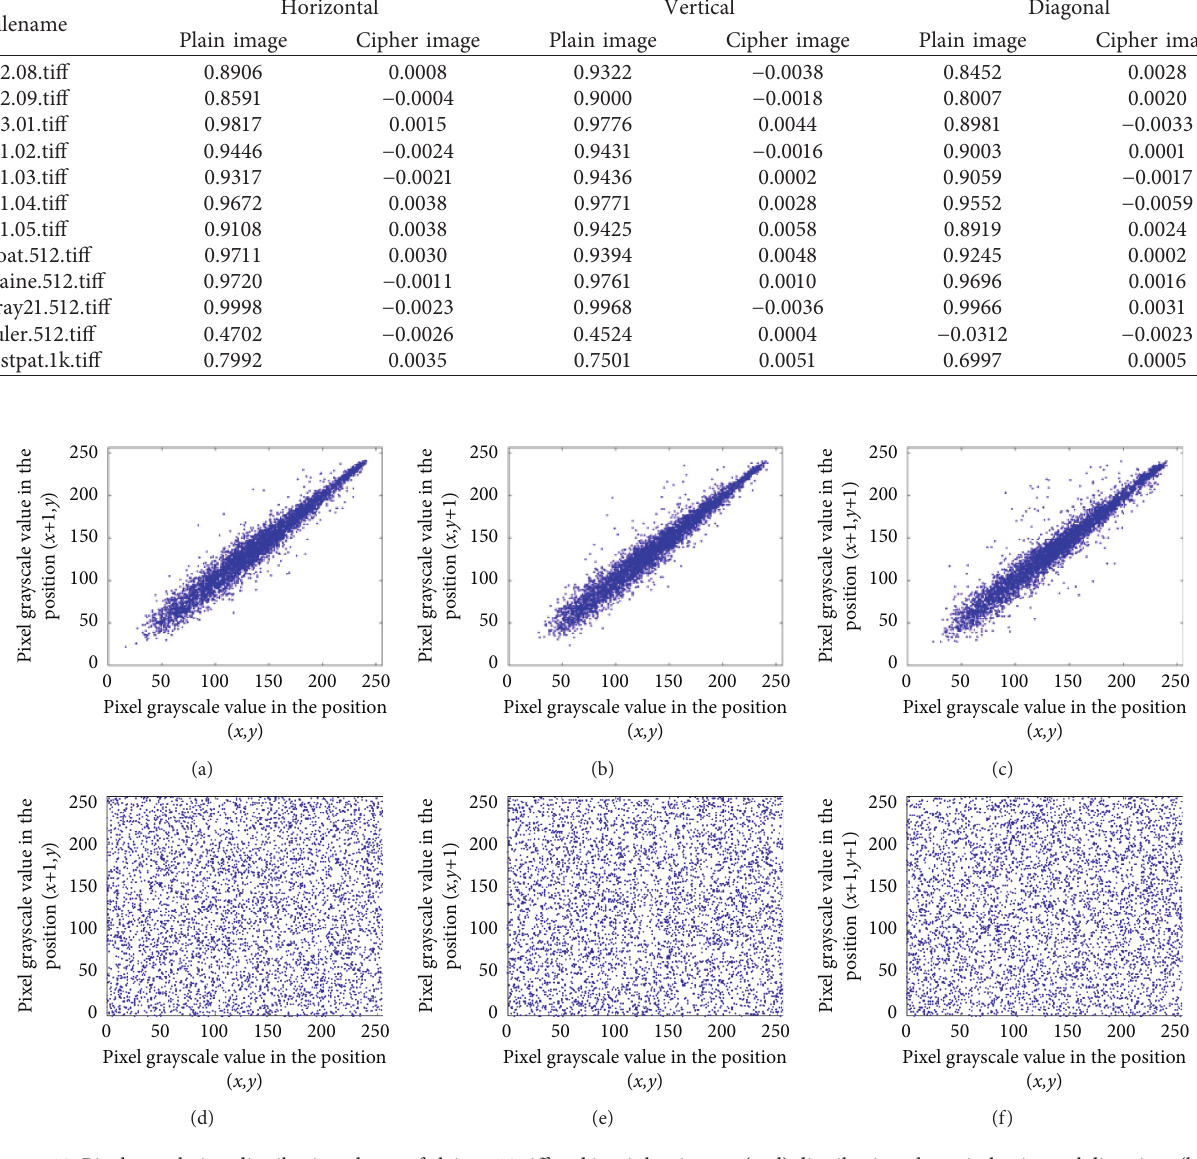
Figure 12: Pixel correlation distribution charts of elaine.512.tiff and its cipher image: (a, d) distribution charts in horizontal direction; (b, e) distribution charts in vertical direction; (c, f) distribution charts in diagonal